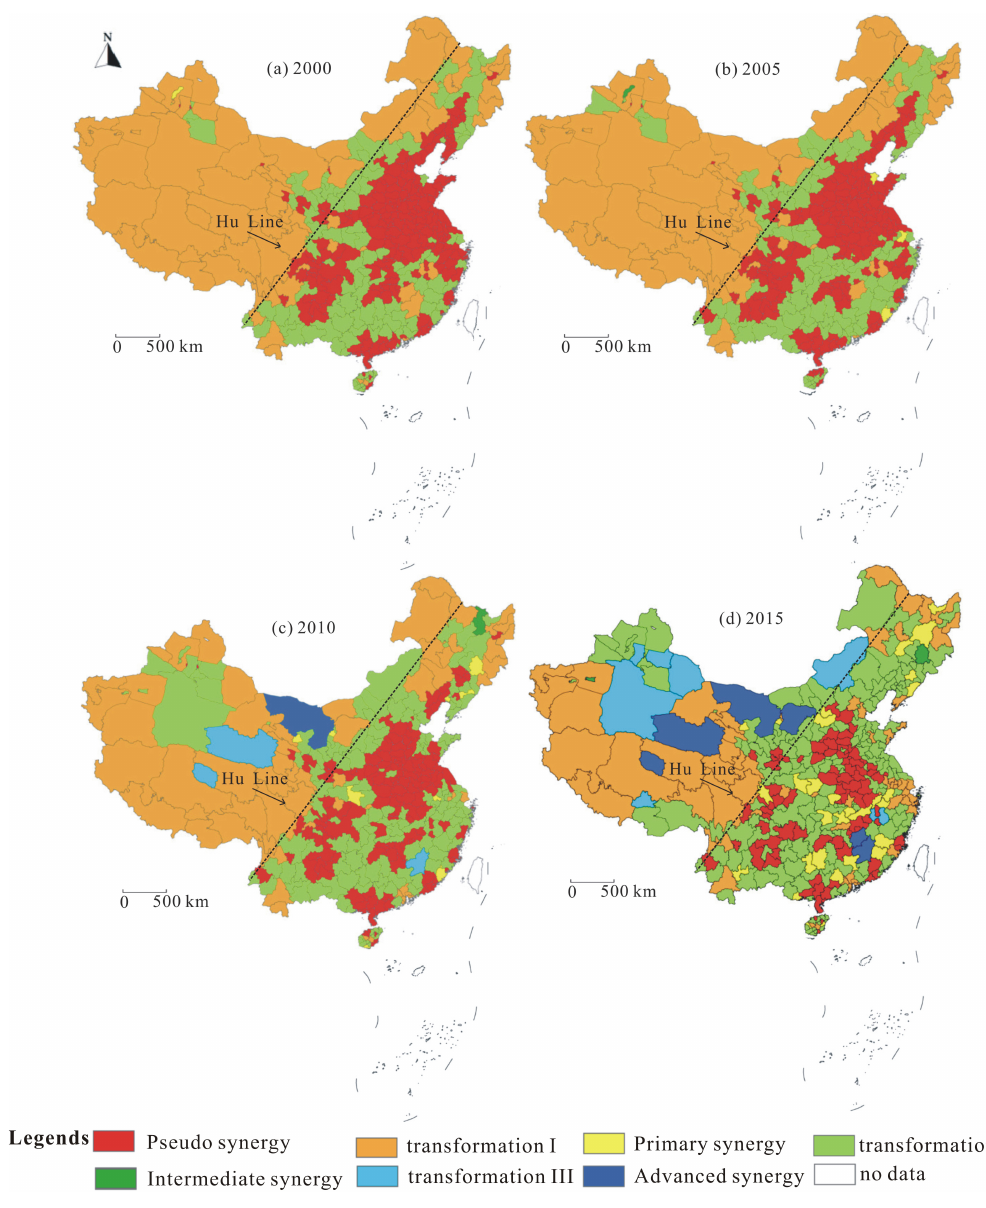
Figure 2. Spatial distribution characteristics of the GEP–GDP synergy in the Chinese mainland during the investigation